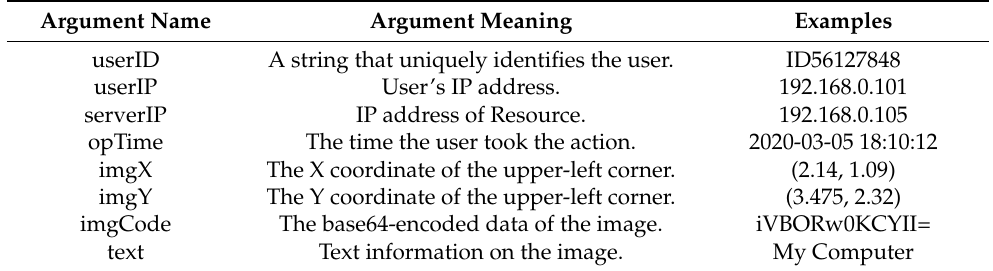
Table 2. Arguments of audit data.